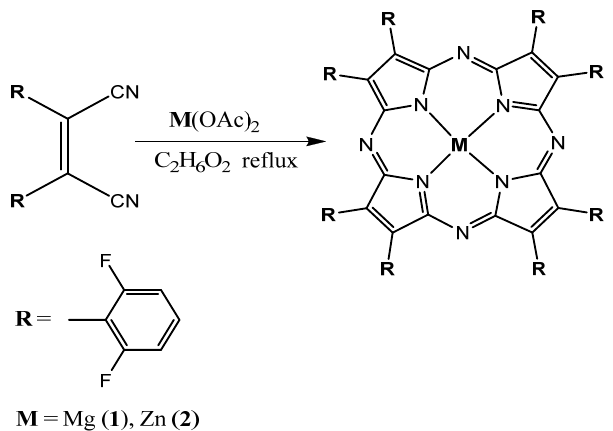
Figure 2. Mass spectra of compounds 1 ( a ) and 2 ( b ). The 1 H NMR spectrum of compound 1 in CDCl 3 shows signals of the meta and para protons of the phenyl rings at 7.33 and 7.66 ppm (Figure S1). In a similar way, boiling of di-(2,6-difluorophenyl)maleindinitrile with zinc acetate in